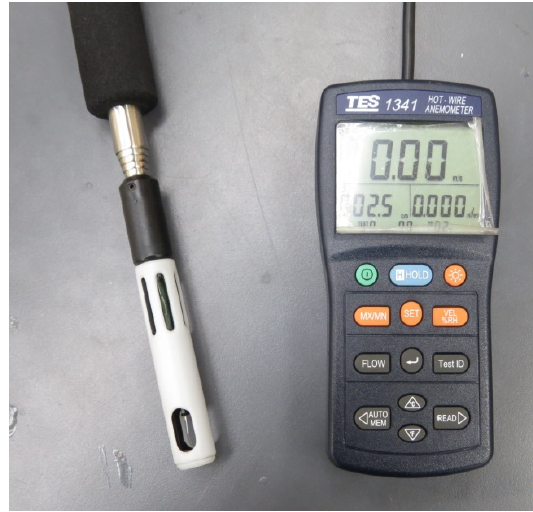
Figure 4. Hot wire anemometer.